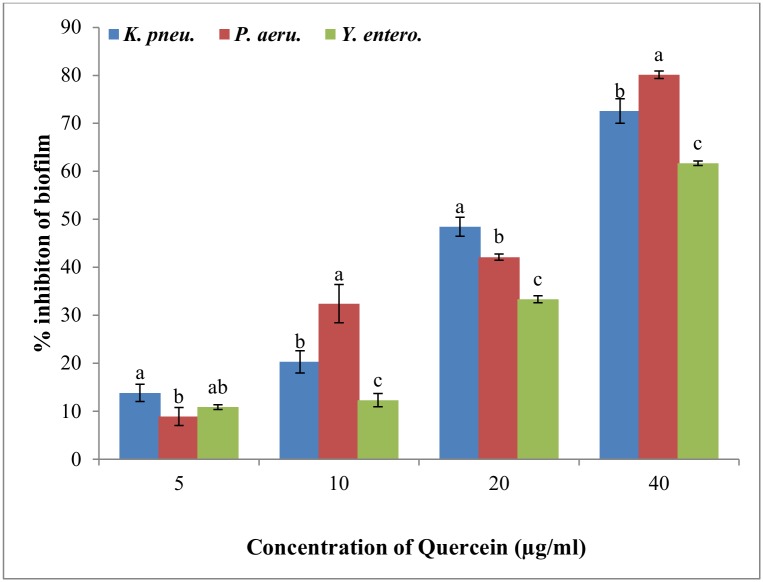
Quantitative analysis for inhibition of biofilm formation in test strains by quercetin at different concentration (0–40μg/ml).Data represented were mean of triplicate values with standard deviation. Same letters in the column are not significantly different (p< 0.05).